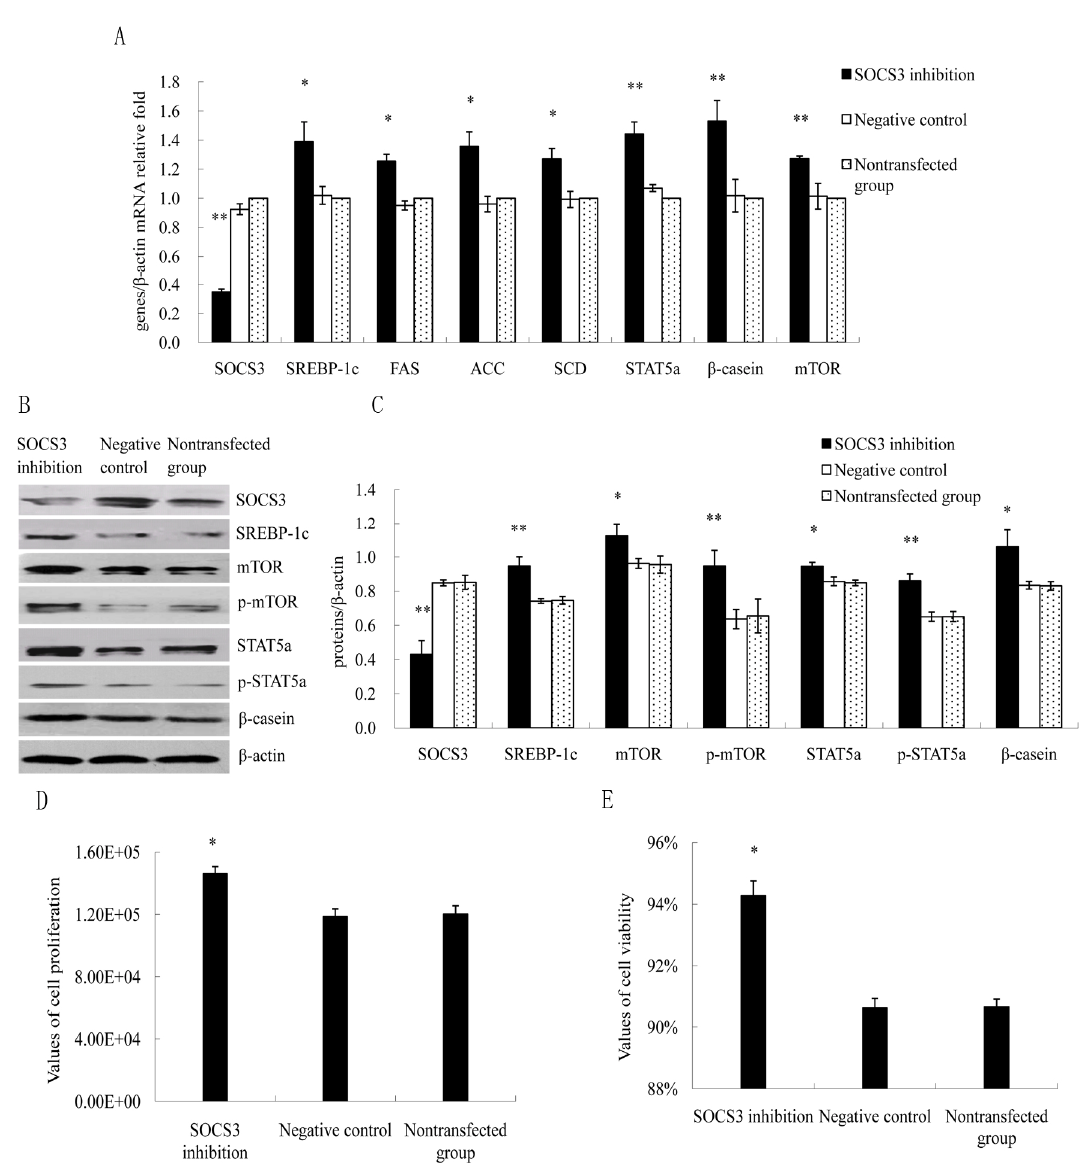
Figure 2. Effect of SOCS3 inhibition on lactation and proliferation of DCMECs. DCMECs were divided into three groups: transfected with a SOCS3 siRNA or negative control (control group), nontransfected, grew for 24 h. ( A ) Relative mRNA expression of different genes in DCMECs growing for 24 h were measured by qRT-PCR after SOCS3 inhibition; ( B ) Western blotting results of SOCS3, STAT5a, p-STAT5a, mTOR, p-mTOR, SREBP-1c, β -casein and β -actin after SOCS3 inhibition in DCMECs growing for 24 h; ( C ) Results of gray scale scan of SOCS3, STAT5a, p-STAT5a, mTOR, p-mTOR, SREBP-1c and β -casein / β -actin relative fold by western blotting after SOCS3 inhibition at 24 h; ( D , E ) Proliferation and viability of DCMECs growing for 24 h were measured using CASY; ( F ) Fluorescence staining after SOCS3 inhibition. a: Cells were transfected with SOCS3 siRNA; b: Negative control; c: Nontransfected cells. Scale bars = 75 μ m in a and b; 20 μ m in c; ( G ) The analysis of fluorescence staining after SOCS3 inhibition. * or ** means significant difference compared with negative control group ( p < 0.05 or p <